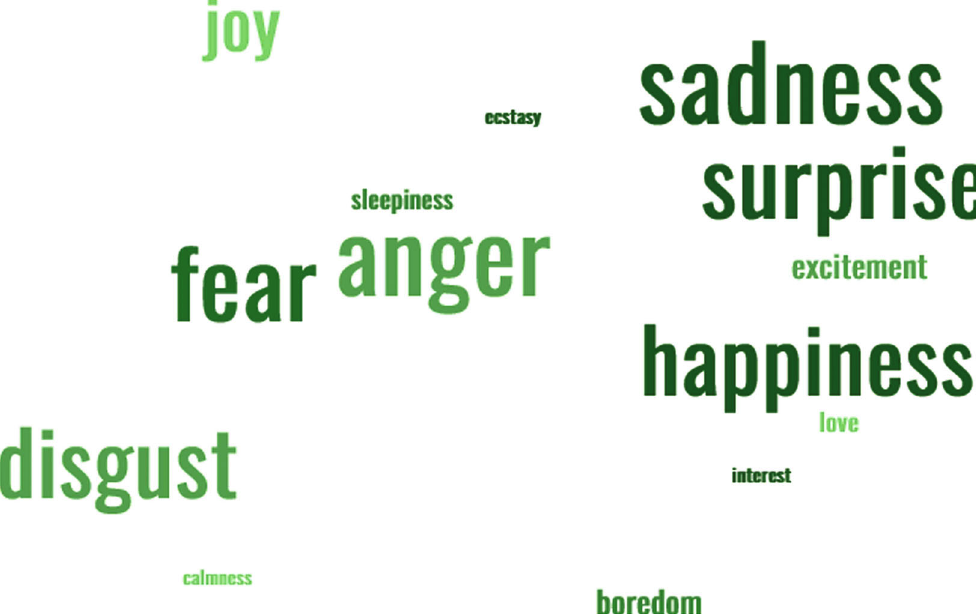
Figure 6: Word cloud showcasing term frequency.Note. Frequency: sadness ( n = 50 ), anger ( n = 48 ), fear ( n = 43 ), surprise ( n = 38 ), happiness ( n = 34 ), disgust ( n = 34 ), joy ( n = 19 ), boredom ( n = 6 ), excitement ( n = 6 ), love (n =5), sleepiness ( n = 5 ), calmness ( n = 4 ), ecstasy ( n = 4 ), interest ( n = 4